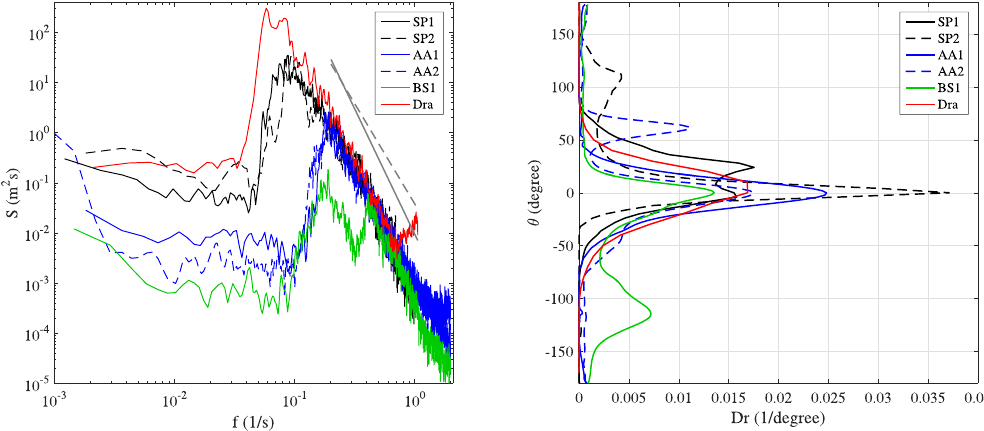
Figure 2. (left panel) Omni-directional frequency spectrum S ( f ). The dashed and solid gray lines are reference spectral slopes proportional to f − 4 and f − 5 , respectively. (right panel) Omni-frequency directional distribution ( Dr ) of the wave energy around the peak direction of the spectrum. As for the Draupner case, the frequency spectrum was computed from the measured time record, whereas the directional distribution was derived from the modeled spectrum.